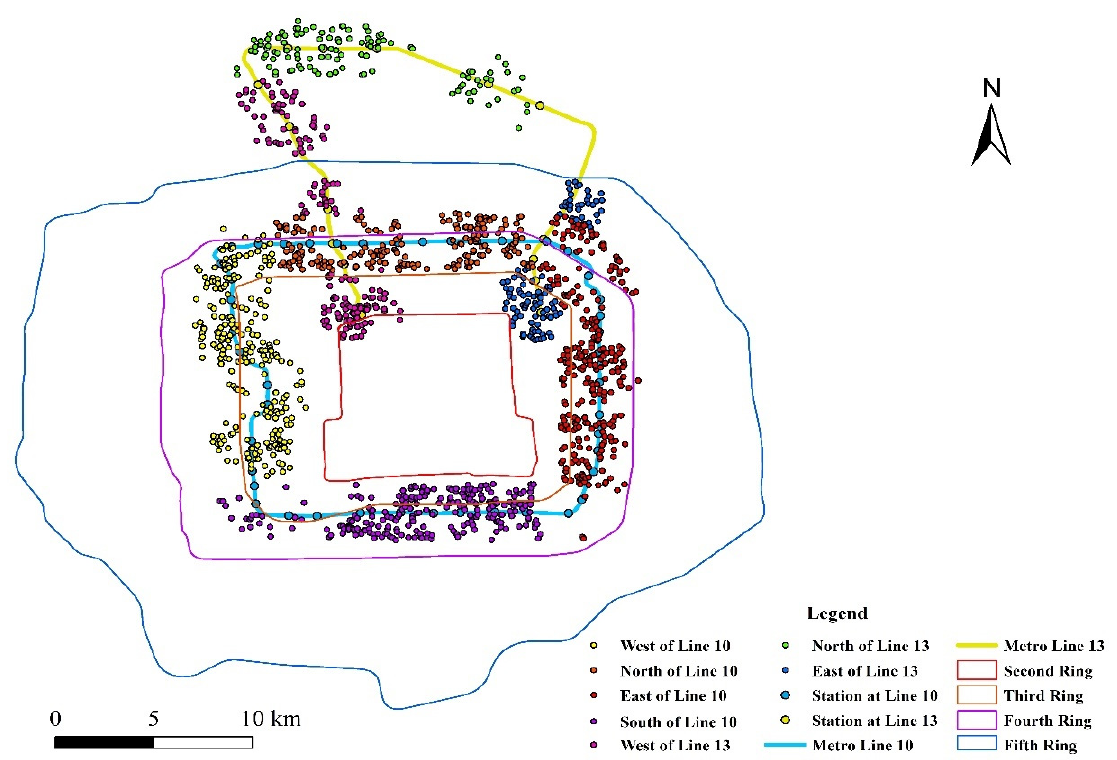
Figure 1. Distribution of stations and sample residences of Beijing Metro Line 10 and Line 13.